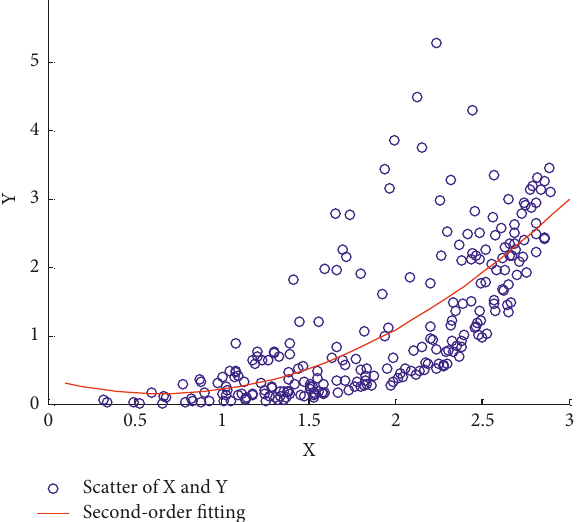
Figure 12: The scatter plot of X and Y and second-order fitting.